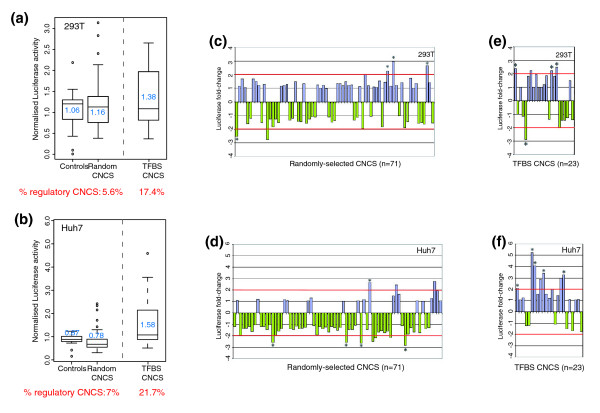
Enhancer/repressor assay of CNCSs. (a, b) Boxplots showing the distribution of the luciferase activity for each subset of sequences in 293T (a) and Huh7 (b) cell lines. The proportion of putative regulatory elements of each subgroup is indicated at the bottom of both graphs. (c-f) Bar graphs showing the fold change of luciferase activity compared to the control sequence set for 71 selected CNCSs (c, d), 23 CNCS overlapping transcription factor binding sites (TFBSs) (e, f), in 293T and Huh7 cell lines, respectively. Red lines show ± 2-fold change threshold. Asterisks denote statistically significant change (one-sample t-test).